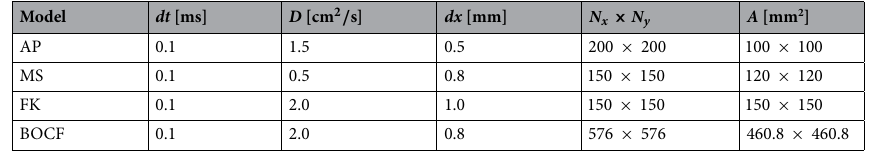
Table 2. This table lists the time step dt , the diffusion constant D , the spatial grid parameter dx , the number of grid points along the x and y axis of the simulation domain N x , N y , respectively, and the resulting system size A for each investigated cell model.